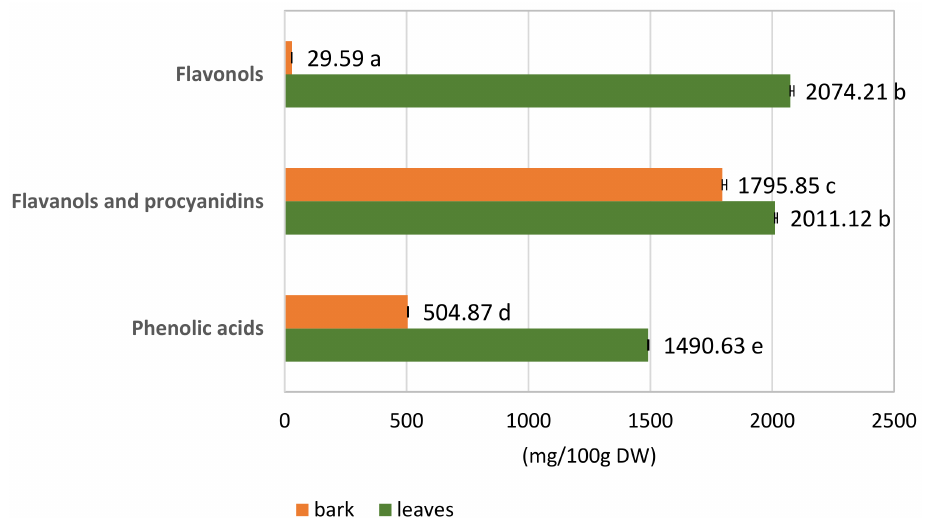
Figure 3. Contents (mg / 100 g DW) ± SD of phenolic compounds in hydromethanolic extracts of leaves and bark of S. alba. Means with the same letter are not statistically di ff erent at p ≤ 0.05 in the Kruskal–Wallis